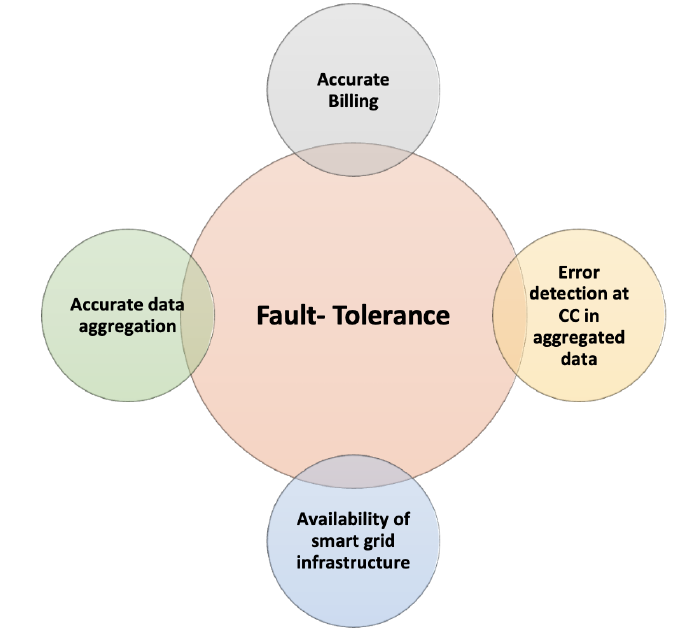
Figure 2. Fault tolerance in the Smart